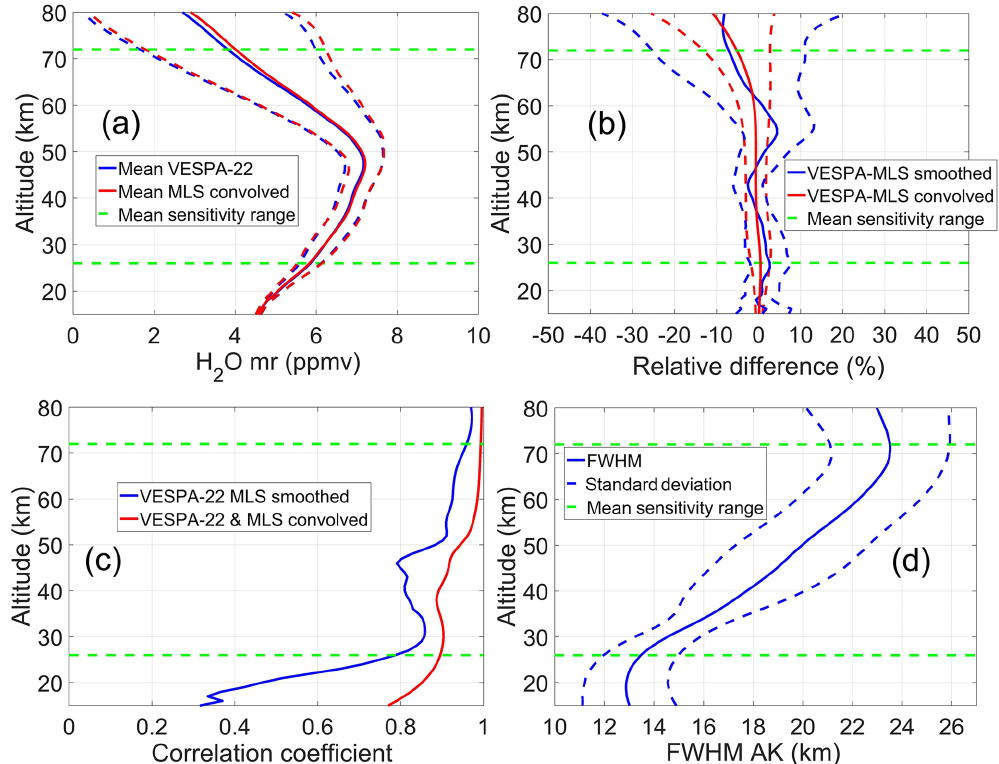
Figure 13. (a) VESPA-22 averaged water vapor mixing ratio vertical profile with its SD (blue line and blue dashed lines) and the mean MLS convolved profile with its SD (red line and red dashed lines); (b) vertical profiles of the mean relative difference between VESPA-22 and MLS convolved (red line), and between VESPA-22 and MLS smoothed (blue line) with their SDs (red and blue dashed lines, respectively); (c) vertical profiles of the correlation coefficient between VESPA-22 and MLS convolved profiles (red line), and between VESPA-22 and MLS smoothed profiles (blue line); (d) vertical profile of the mean FWHM of VESPA-22 averaging kernels with its SD. The data used for the intercomparison range from 12 July 2016 to 2 July 2017. The green dashed horizontal lines display the mean altitudes of the sensitivity range